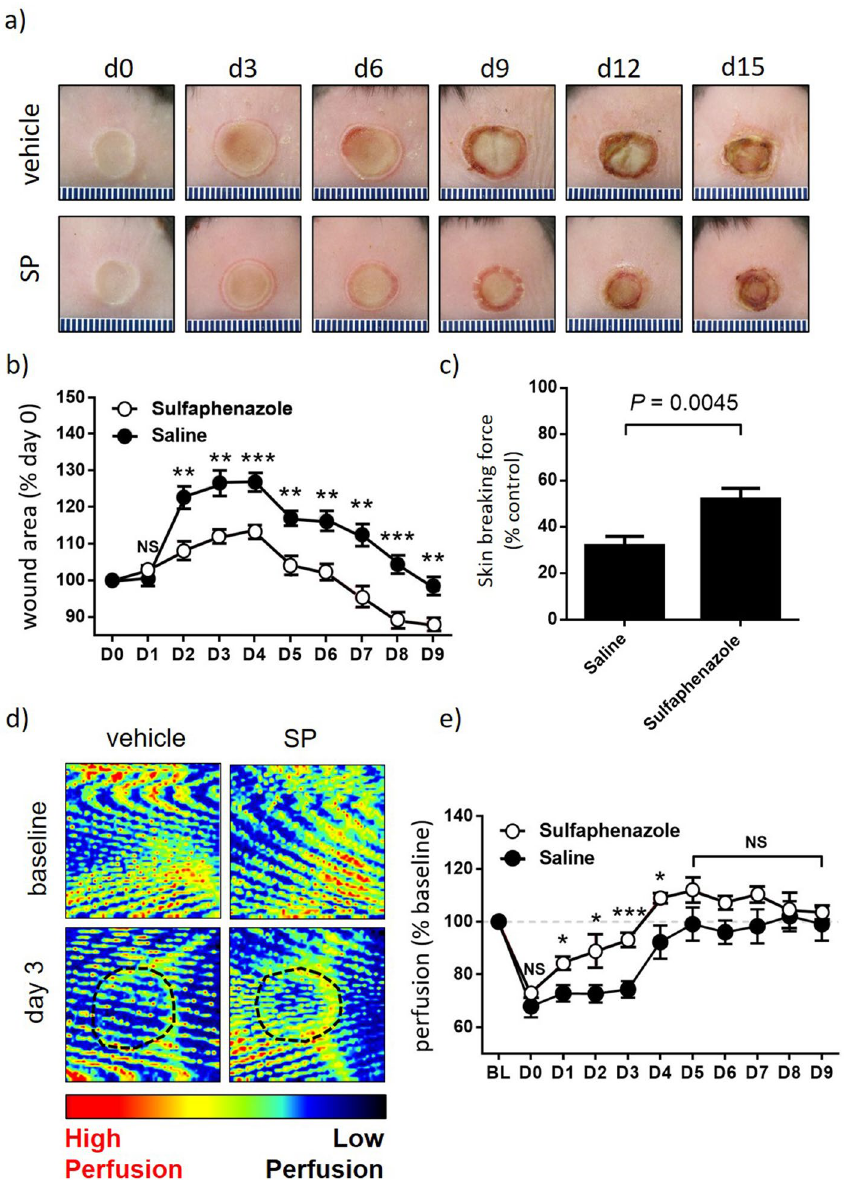
Figure 1. SP reduces burn injury severity. ( a ) Representative thermal injury photos. ( b ) Macroscopic measure of wound area with data presented as mean ± SEM at each time point, n = 6. ( c ) Minimum wound breaking force at d15 post-injury, n = 6 wounds per group. ( d ) Representative Doppler images of burn injury tissue. Region of interest (ROI) indicated by black dotted lines. ( e ) Quantification of tissue perfusion in ROI. Data evaluated as perfusion per unit area and presented as % baseline, mean ± SEM, n = 6. * P < 0.05, ** P < 0.005, ***P<0.0001. Data analyzed by two-way ANOVA with Bonferonni post-hoc